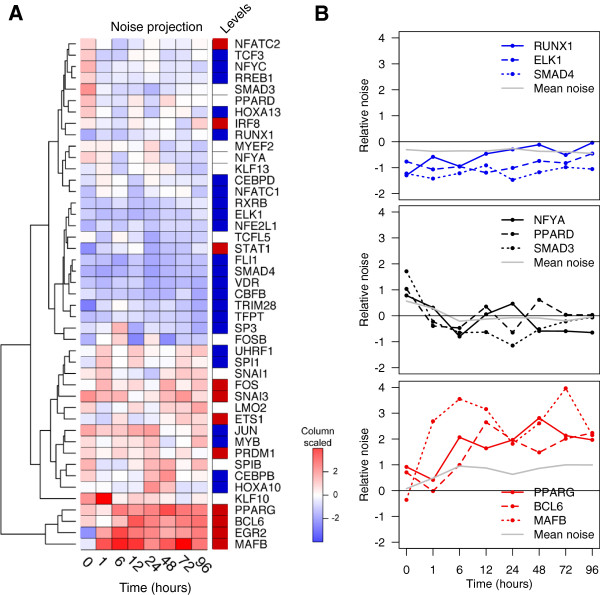
Propagation of noise strength in respect to the THP-1 network. (A) A heat map cluster representing scaled noise-strength for each TF across the time course (scaled z-score: red = noisy, blue = less noisy). Each TF is color-coded based on the topological layers of the THP-1 network (dark blue = upstream, white = midstream, dark red = downstream). (B) Noise projections of selected TFs and the mean noise strength for each topological layer (grey).